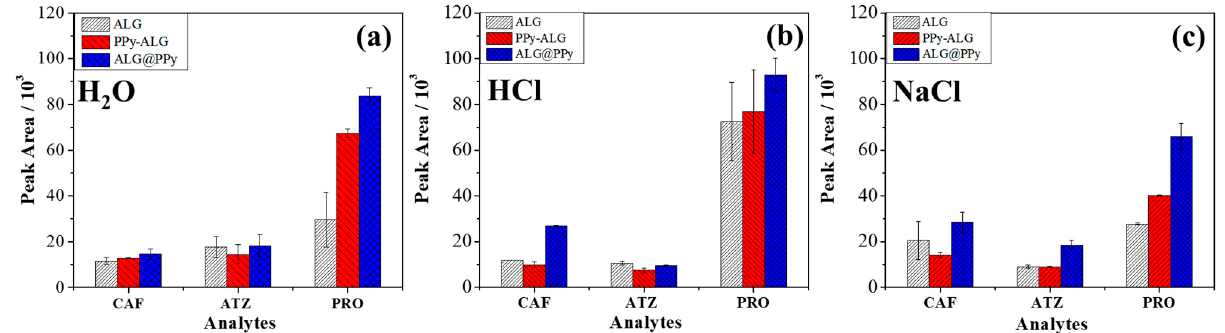
Figure 4. GC-MS peak area (replicates = 2) of CAF, ATZ, and PRO (0.5 mg mL − 1 ) after extraction using ALG, PPy-ALG and ALG@PPy hydrogel beads in ( a ) ultrapure water, ( b ) HCl 0.1 mol L − 1 and ( c ) NaCl 0.1 mol L − 1 . The order of increasing polarity of the contaminants is: CAF > ATZ > PRO.